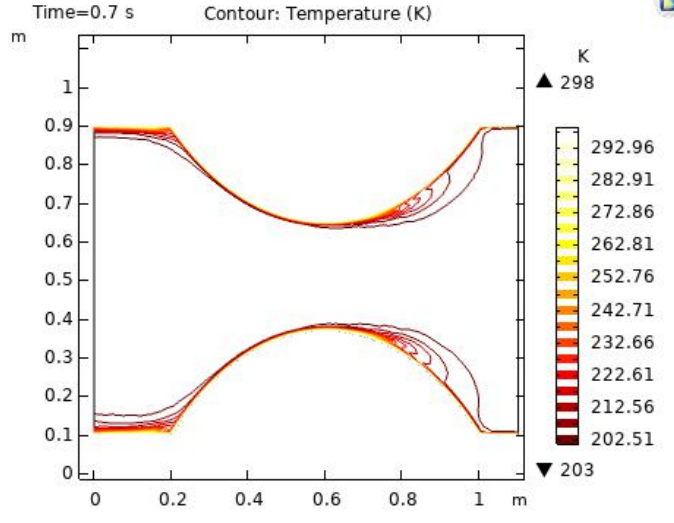
Figure 18. The isothermal contour profile at t = 0.7 s.